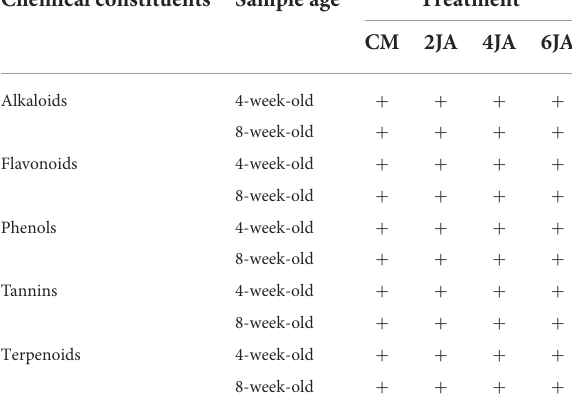
TABLE 2 Qualitative screening of phytochemical constituents in green callus of A. indica methanolic extract. Chemical constituents Sample